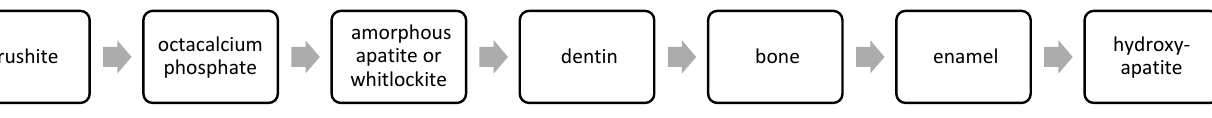
Figure 1. Postulated evolution of substances changes.